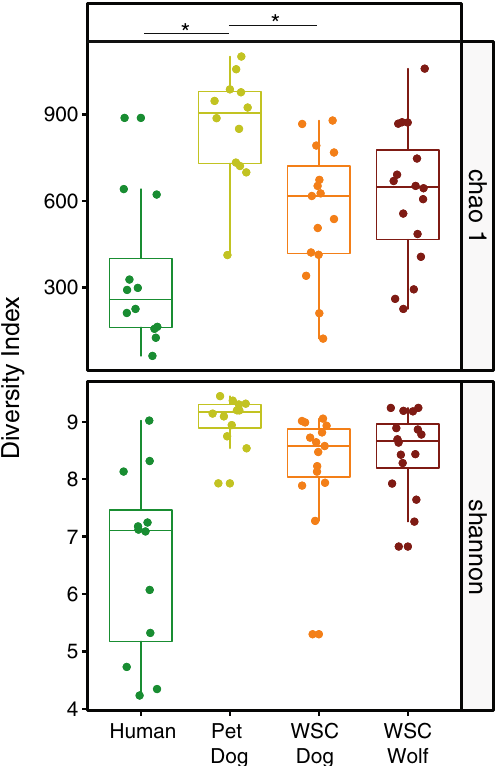
Figure 1. Species richness of microbiota of humans, pet dogs, WSC dogs, and WSC wolves are displayed as Chao1 index and alpha diversity as Shannon index. An asterisk indicates a p value below 0.05 when conducted pairwise Kruskal–Wallis test for both indices. All four groups differed significantly among each other in the pairwise comparison for the Chao1 and Shannon indices (all p values ≤ 0.05), except for the WSC dog group versus the WSC wolf group (both p values ≥